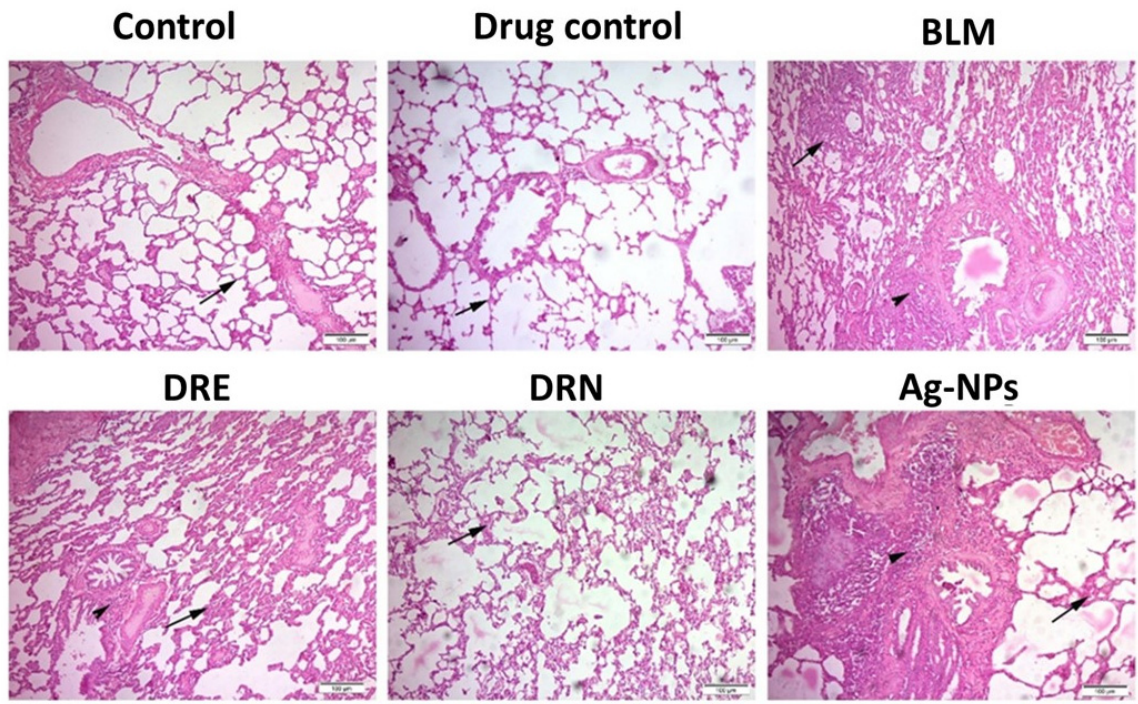
Figure 2. Effect of DRE and DRN on lung histopathology in BLM male Swiss albino rats (H&E × 100; image resolution 300 DPI).